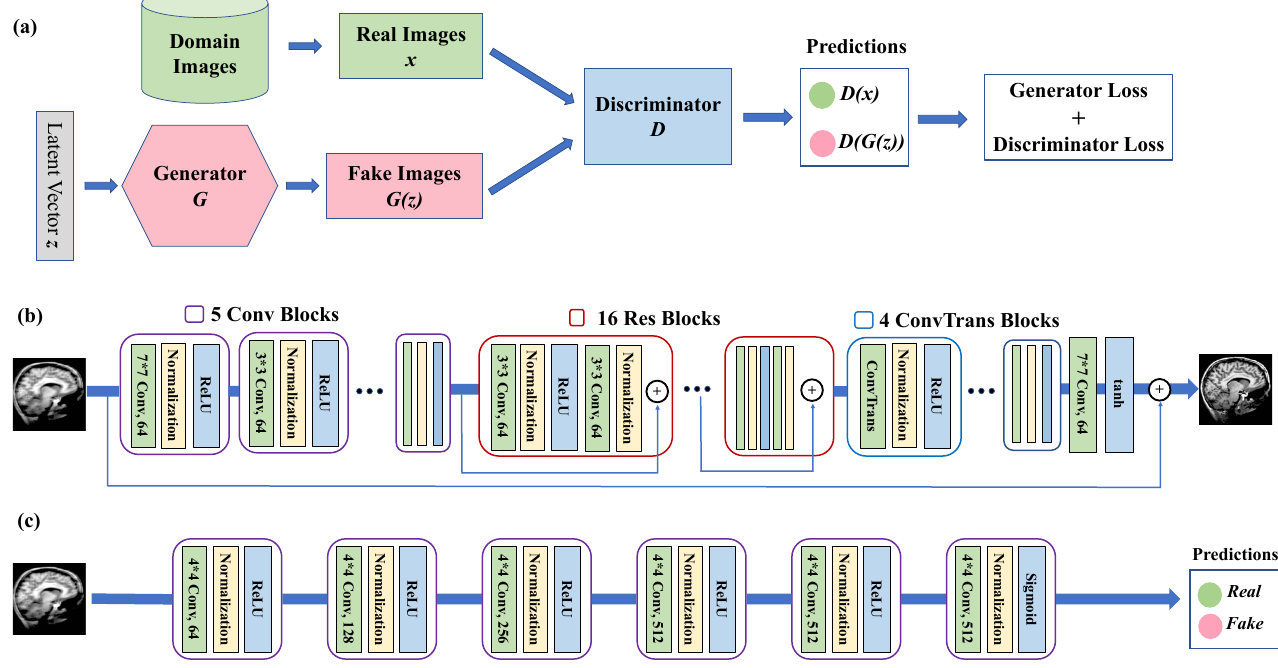
Figure 1. Architecture of MC-GAN Model. ( a ) Overall GAN structure. ( b ) MC-GAN generator. ( c ) MC-GAN